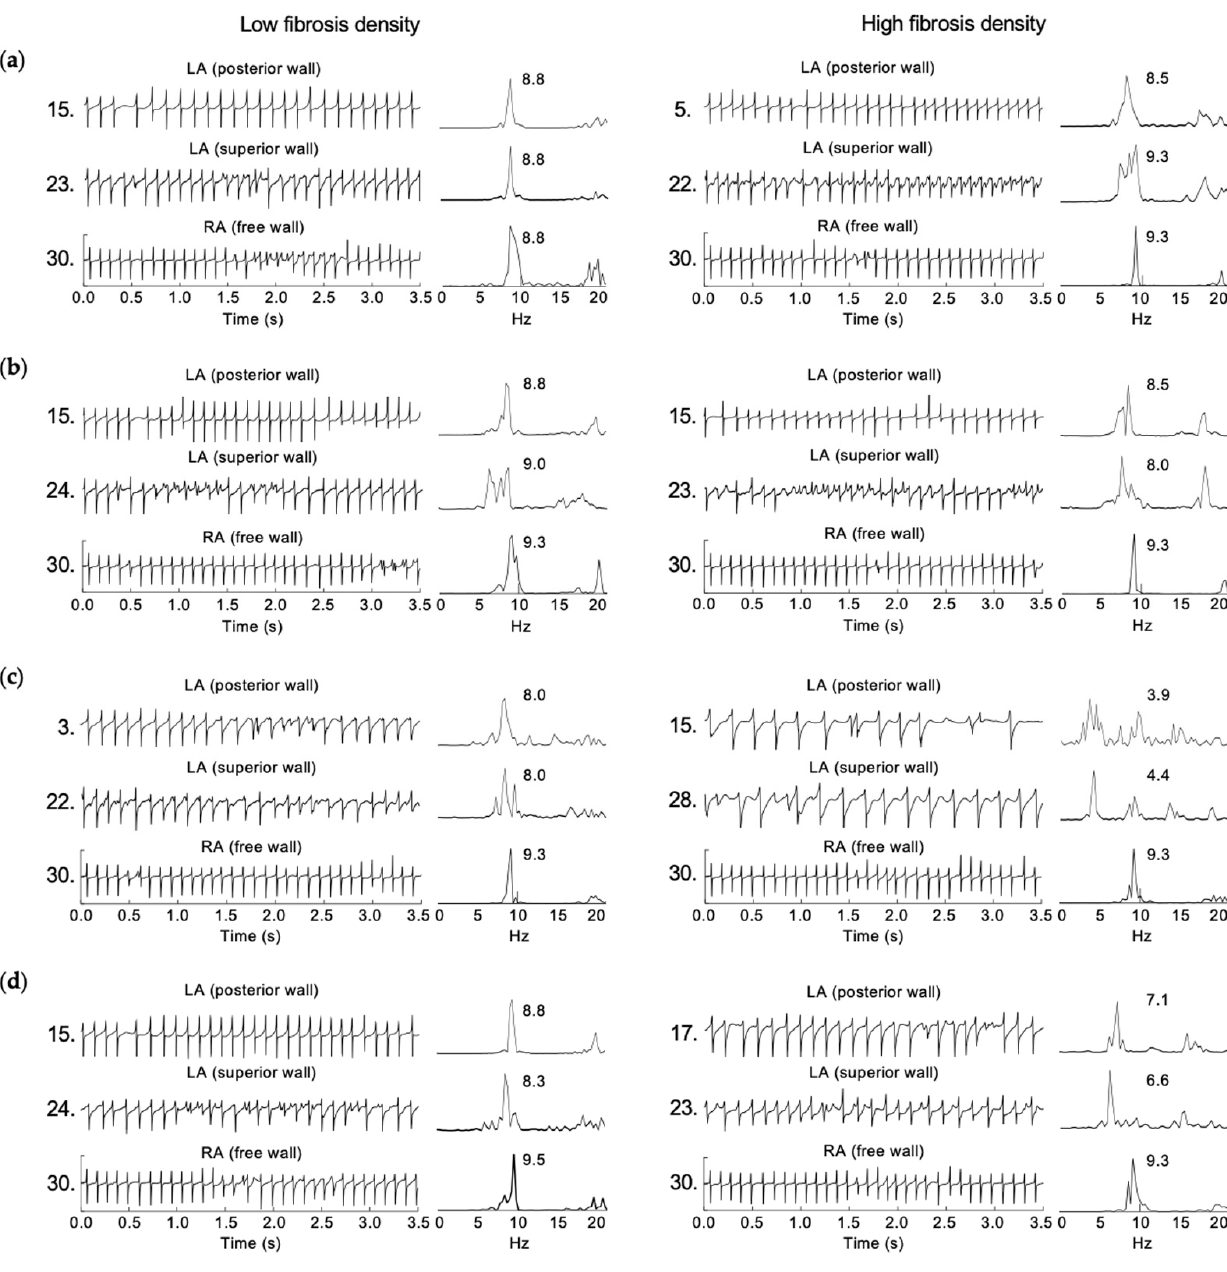
Figure 4. EGMs and their respective spectra at three representative locations in right (RA) and left (LA) atria, for the follow configurations at low (left) and high (right) density: ( a ) fibroblasts, ( b ) myofibroblast, ( c ) fibrocytes, and ( d ) fibroblasts + myofibroblasts + fibrocytes. The DF values are shown.